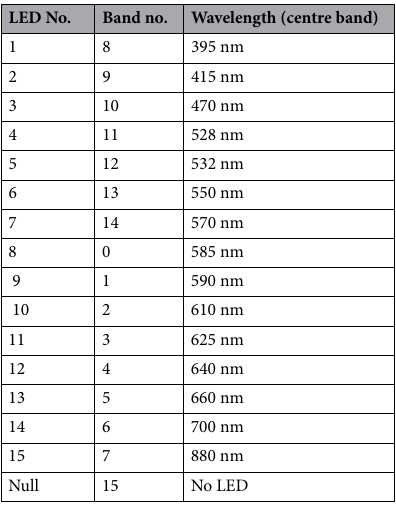
Table 4. Detailed wavelength information used in the A-MSI